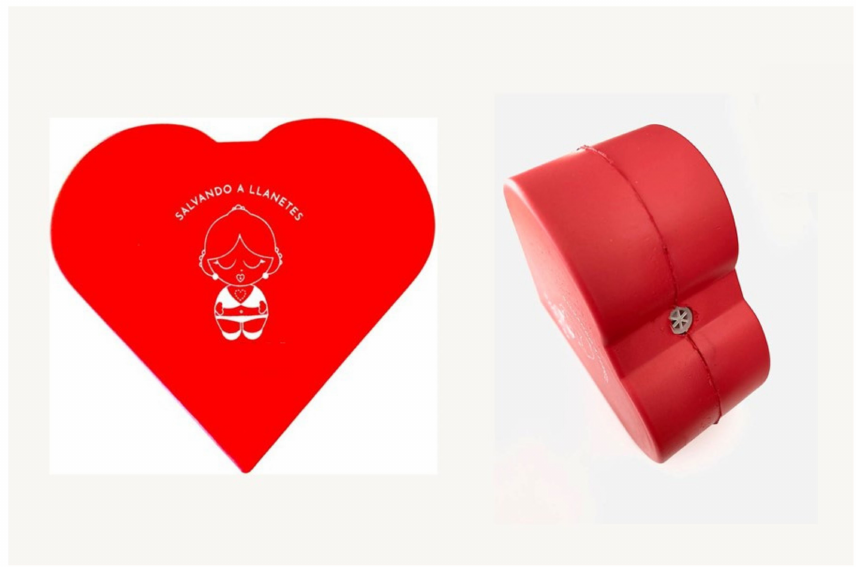
Figure 1. Heart of the auditory feedback device “Salvando a Llanetes ® ”.